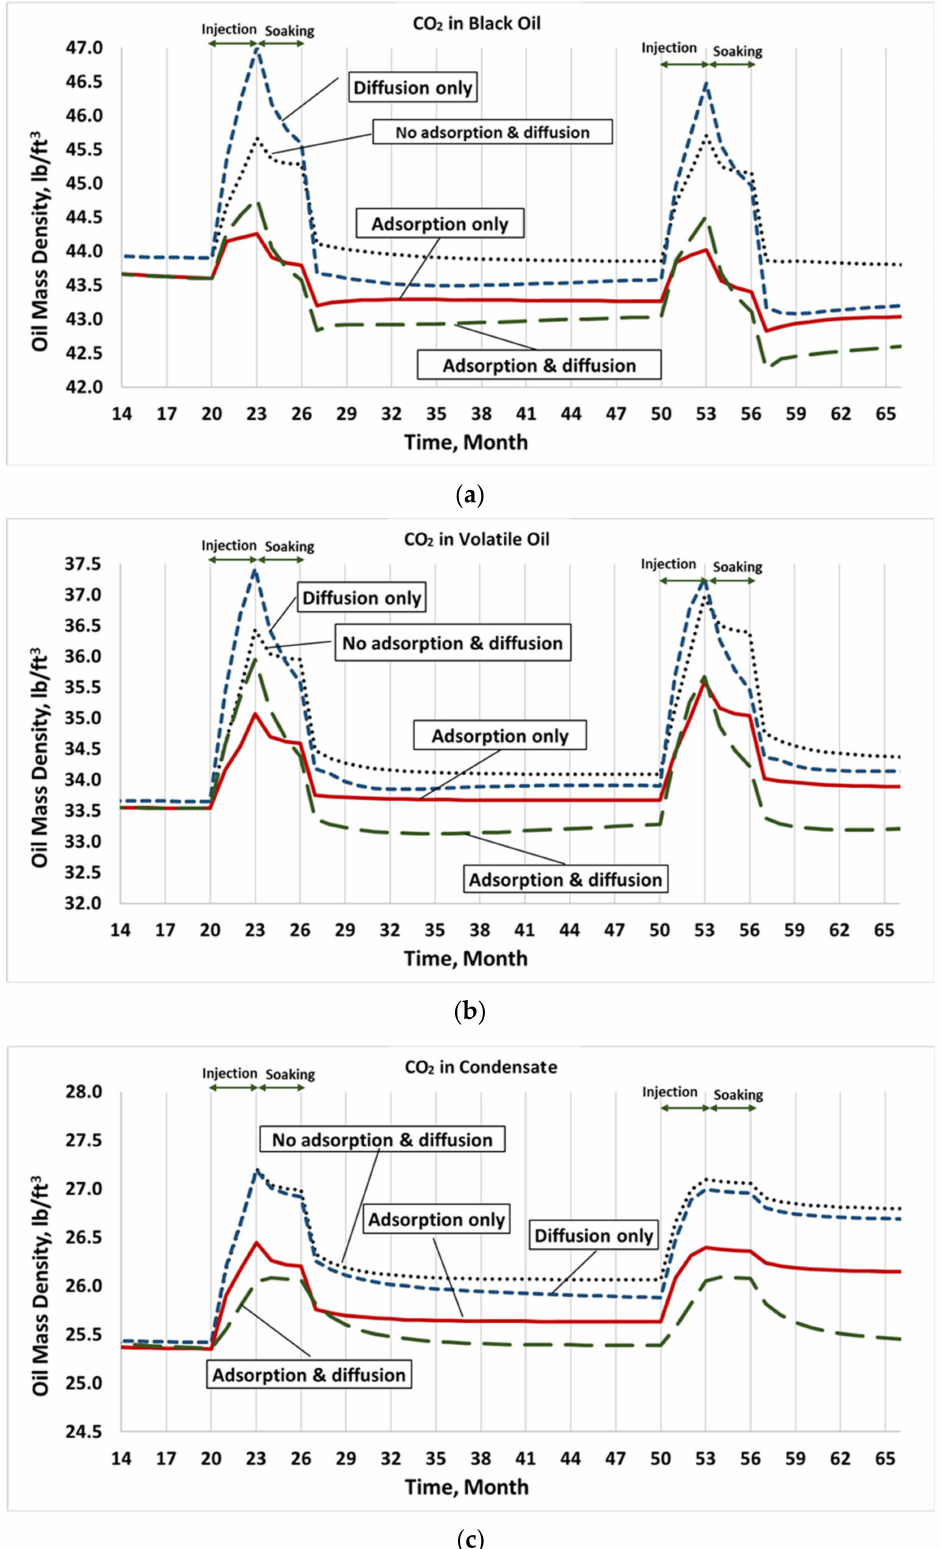
Figure 8. Diffusion and adsorption impact on the oil density changes near the fracture/matrix interface for CO 2 injection in ( a ) black oil, ( b ) volatile oil, and ( c ) condensate